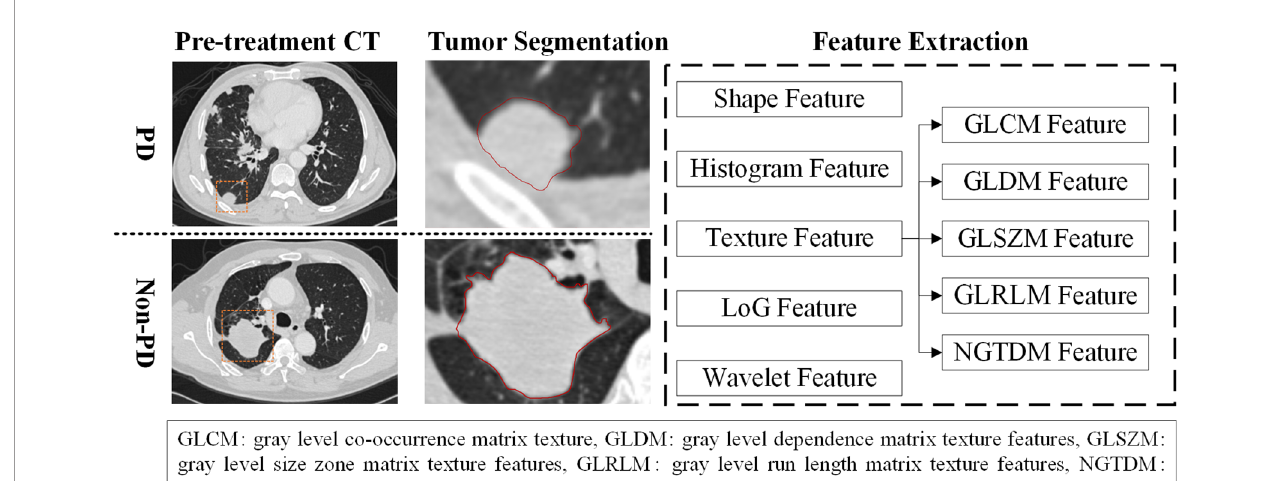
FIGURE 2 | The radiomics feature extraction process.